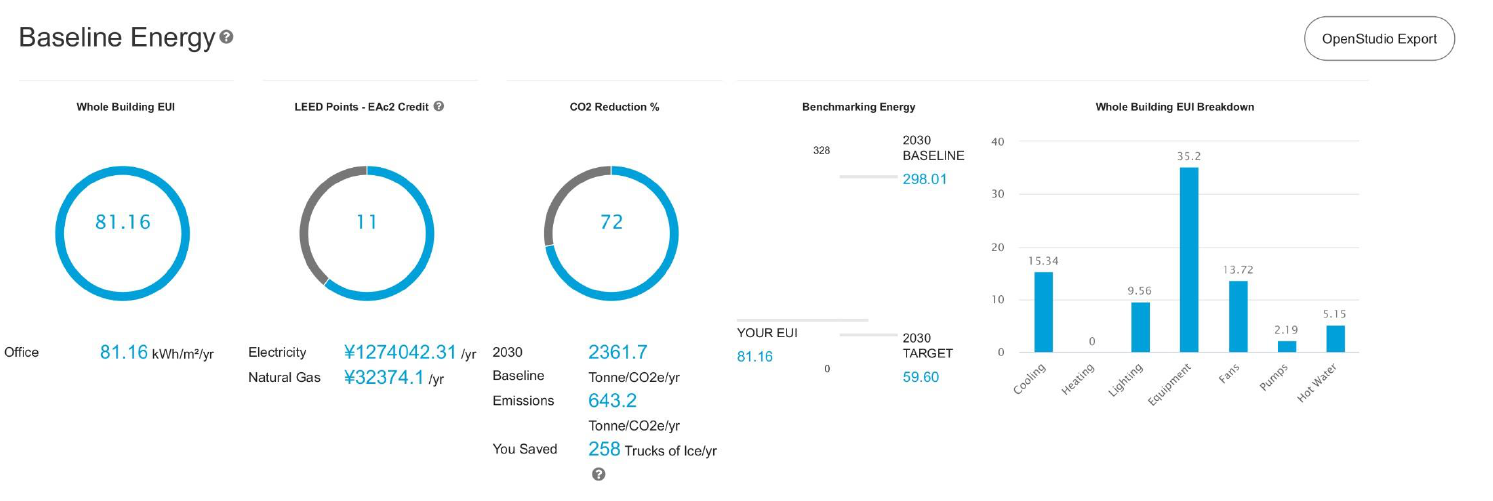
Figure A2. Zone 1-A Haikou, Hainan (post-COVID-19 78% scenario).